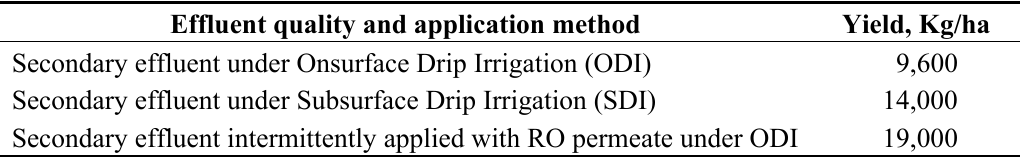
Table 7. Red pepper yield under various effluent qualities and application